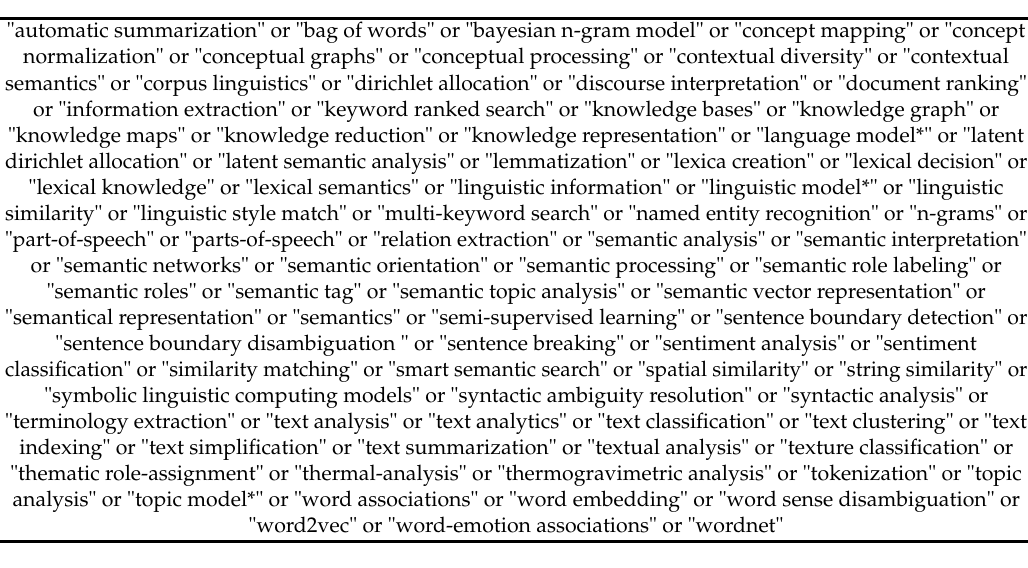
Table A1. Final keywords list for NLP research in data retrieval.